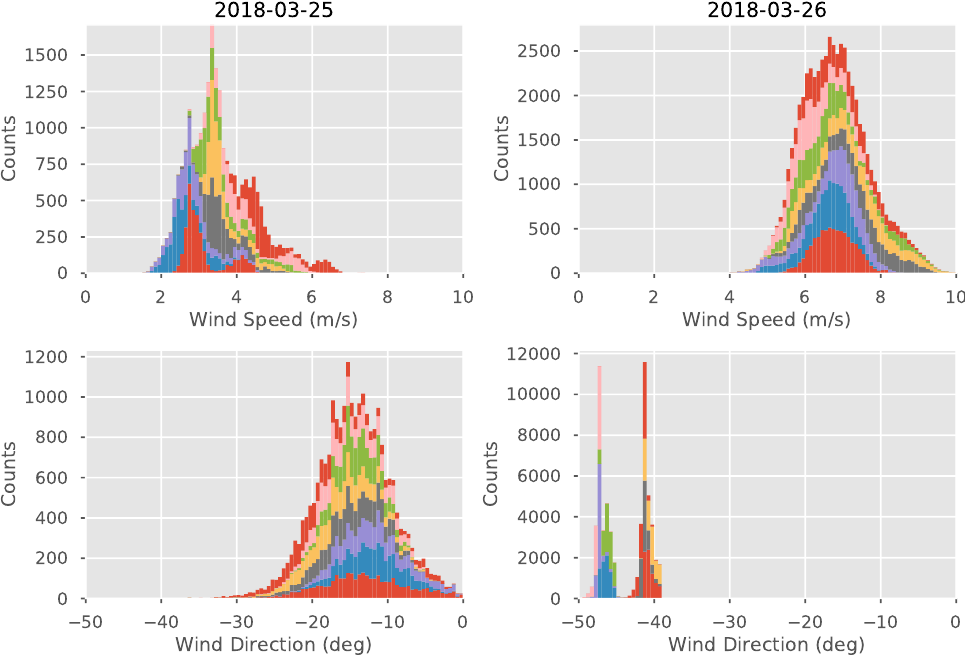
Figure 5. Histograms (colors represent different DopplerScatt lines, defined as continuous data collections with constant heading) stacked in time order for wind speed (top row) and direction (bottom row). The left column is for 2018-03-25, while the right column is for 2018-03-26. All data estimated by